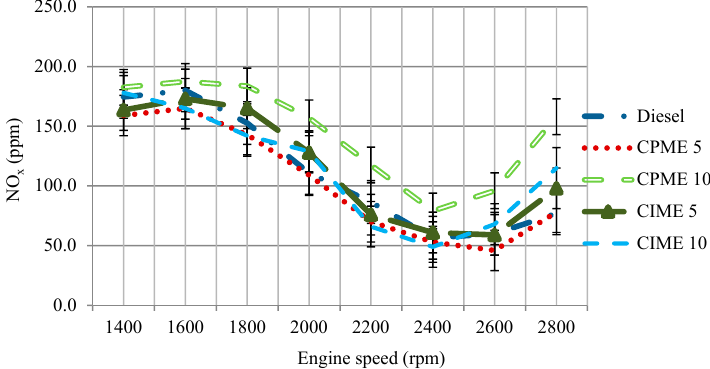
Figure 3. Changes in Nitrogen Oxide (NO x ) emissions of diesel, CPME, and CIME blends with speeds.